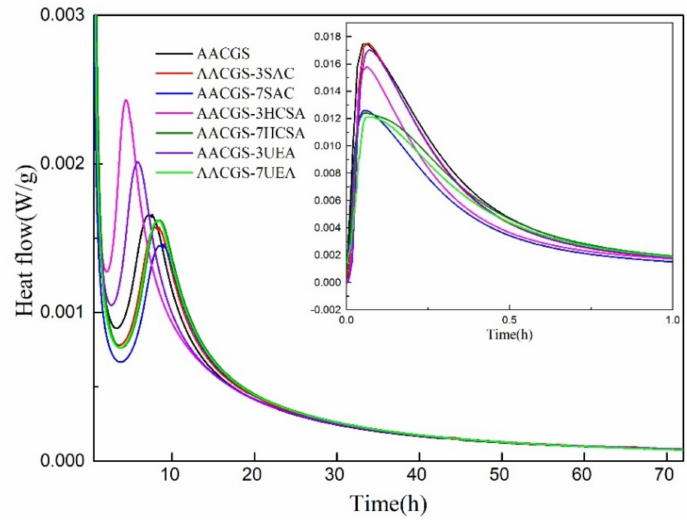
Figure 1. Influence of mineral admixture on reaction heat